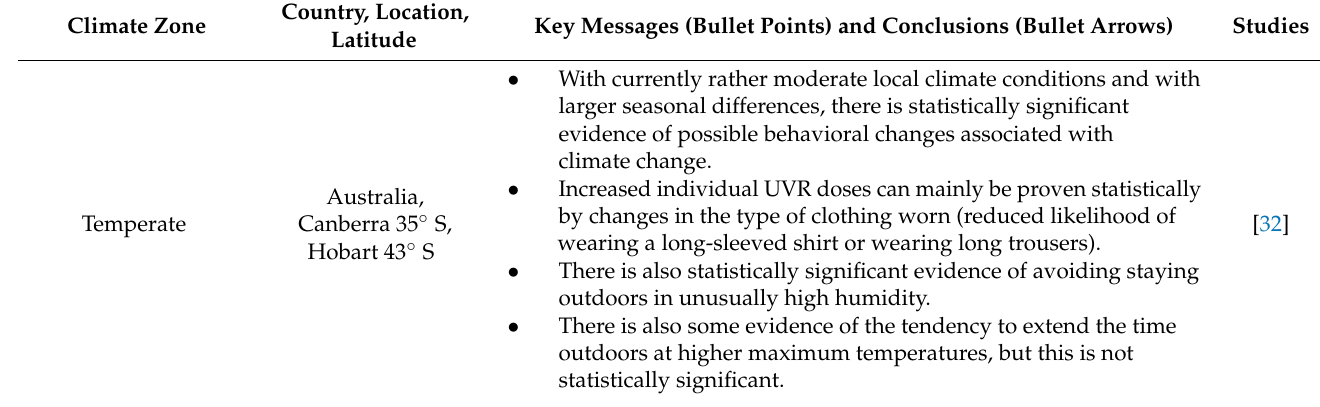
Table 2. Summary of the key messages and conclusions from the type I studies. Key Messages (Bullet Points) and Conclusions (Bullet